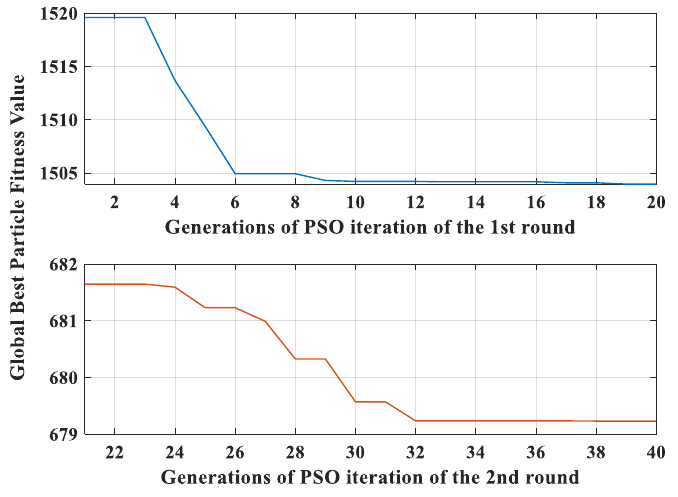
Figure 12. Fitness of desuperheater controller A.